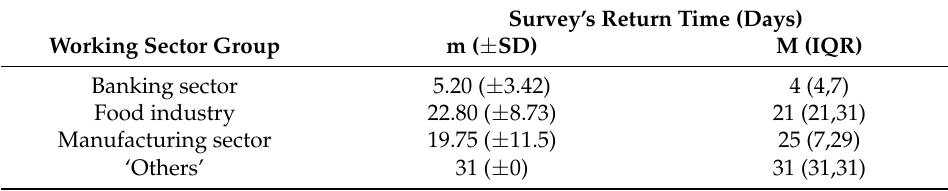
Table 2. Framework of the survey’s return time.